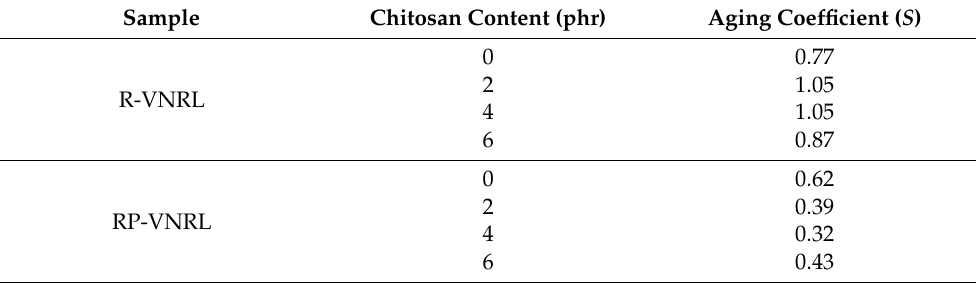
Figure 6. Percentage swelling (swelling ratio) of non-aged and thermal-aged ( a ) CS/R-VNRL com- posites and ( b ) CS/RP-VNRL composites, with varying CS contents of 0, 2, 4, or 6 phr. Error bars indicate ± standard deviation. Table 5. Aging coefficients ( S ) of non-aged and thermal-aged CS/R-VNRL and CS/RP-VNRL composites with varying CS contents of 0, 2, 4, or 6